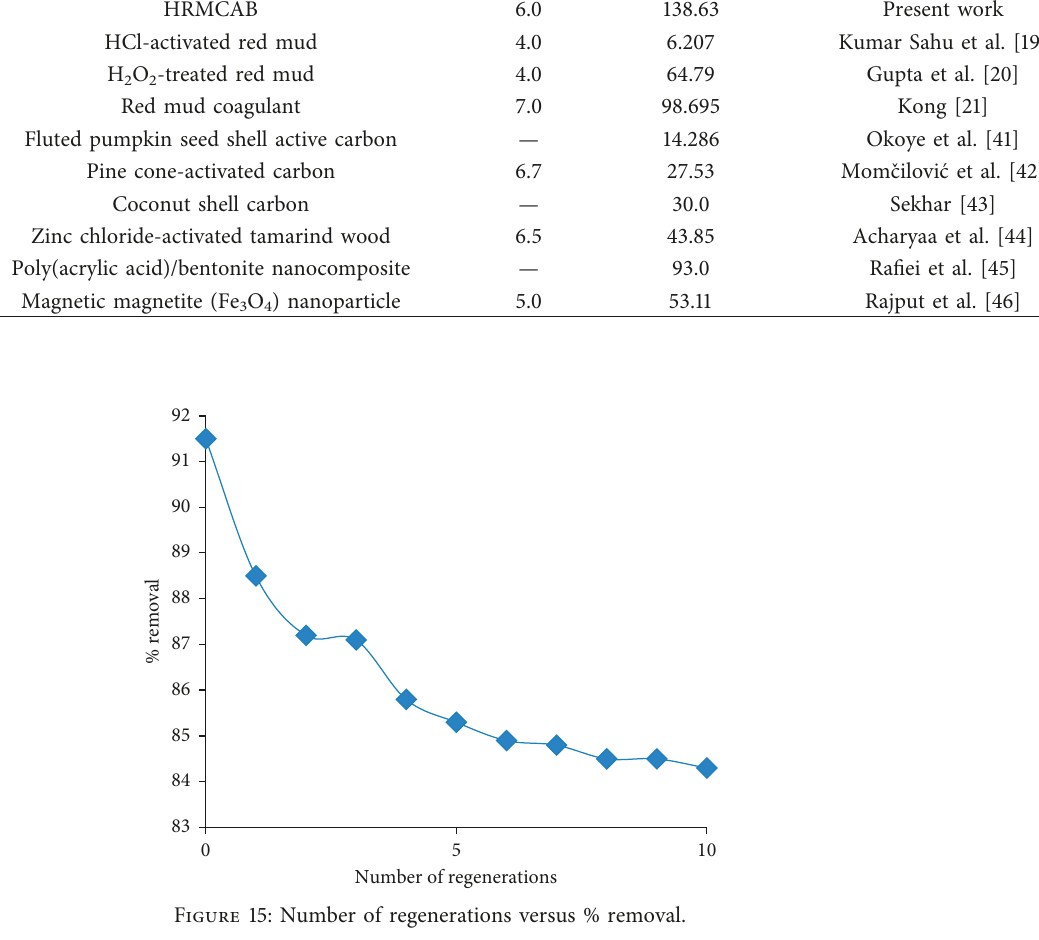
Table 6: Comparison of maximum adsorption capacity of the adsorbent with other adsorbents from the literature. S. number